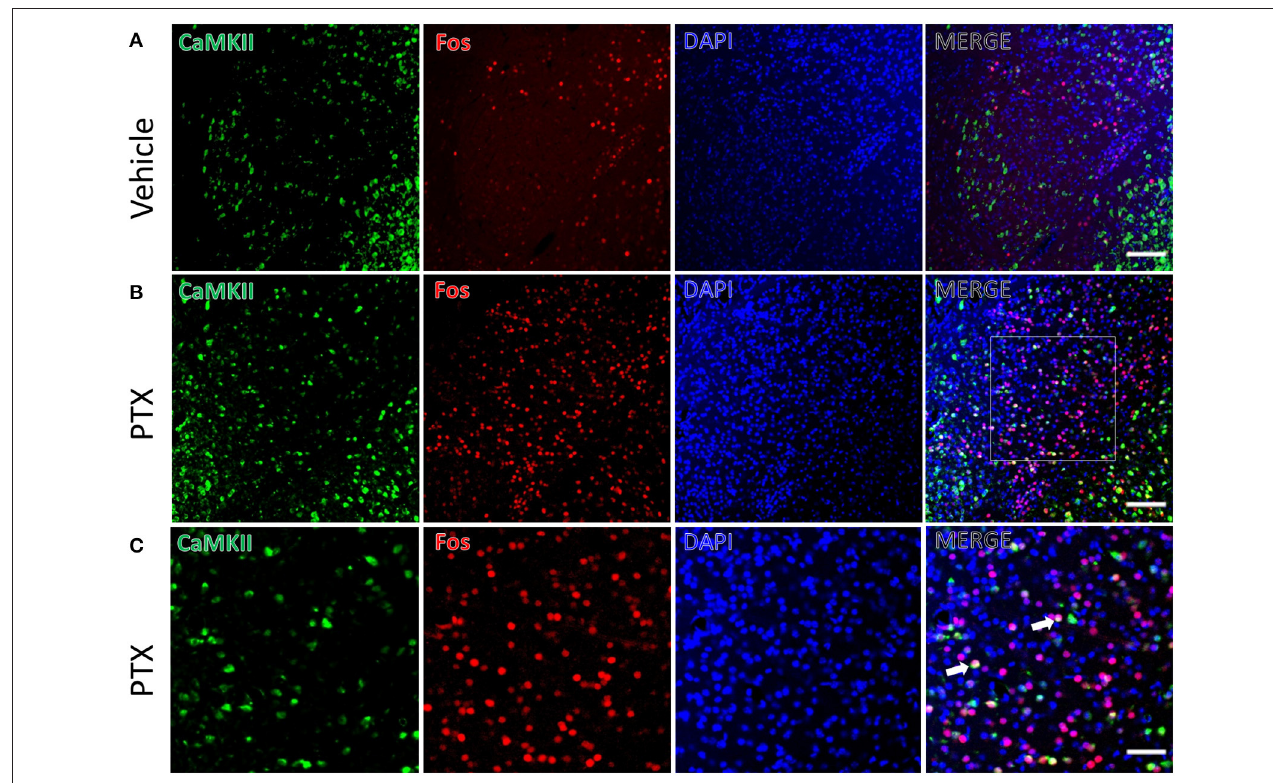
FIGURE 3 | CaMKII neurons in the CeA are activated in paclitaxel-treated mice. (A) The expression of CaMKII (green) and Fos (red) in CeA area of the vehicle group. (B) The expression of CaMKII (green) and Fos (red) in CeA area in paclitaxel group. (C) The magnified images of the rectangles indicated in (B) . Arrows indicate part of CaMKII and Fos double-labeled neurons. n = 3 mice per group, 2 sections per mouse. Scale bars = 100 µ m in (A) [applies to (B) ]; 50 µ m in (C) .